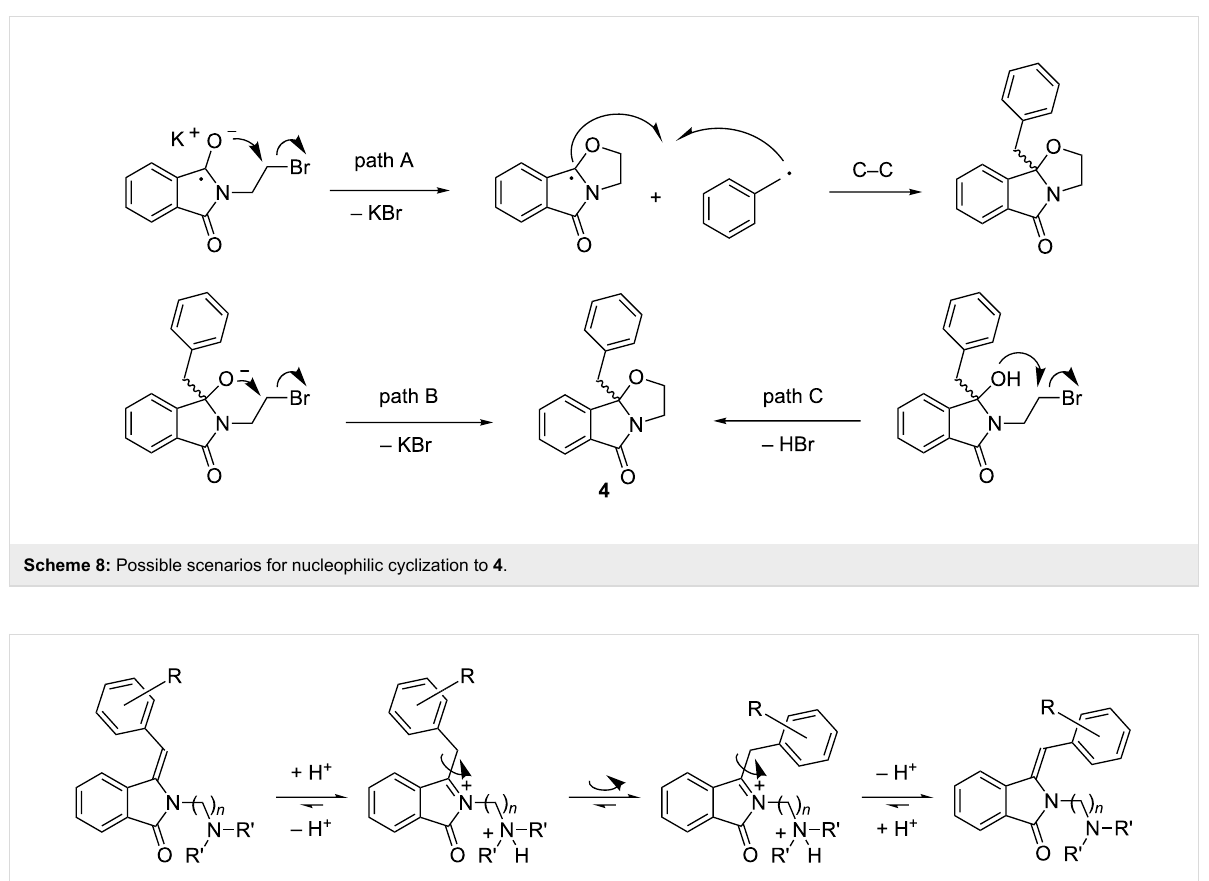
Scheme 9: Possible E / Z isomerization for compounds 8a–y